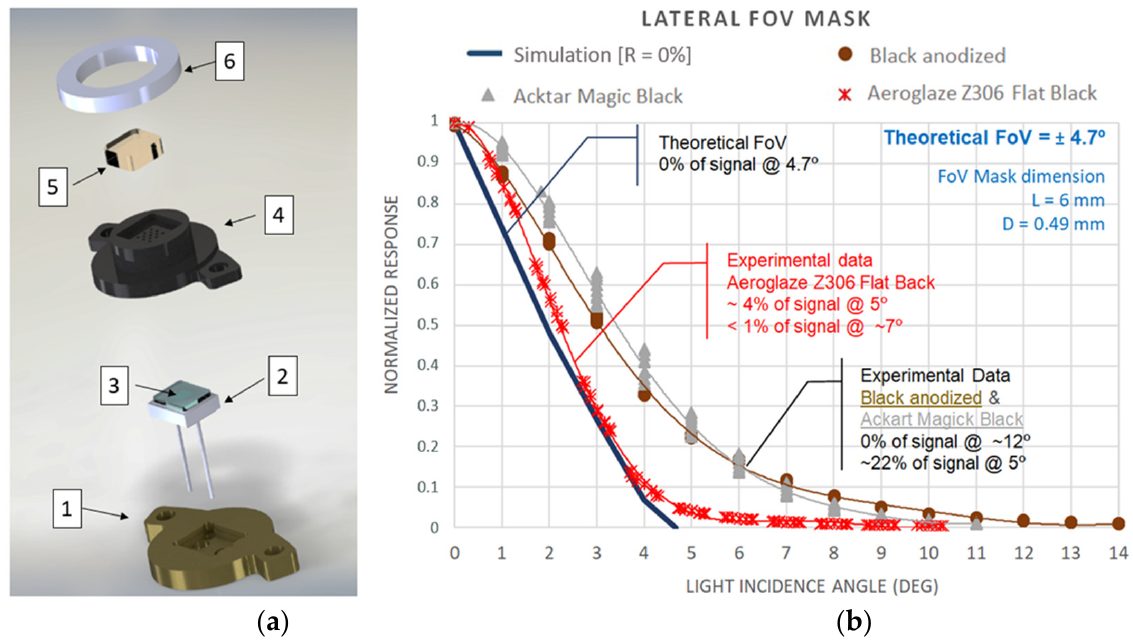
Figure 4. RDS optomechanical sets: ( a ) detail of the exploded view of a TOP channel subassembly: (1) radiation shield, (2) photodiode, (3) interferential filter, (4) FoV mask, (5) sapphire window, and (6) samarium–cobalt magnet; ( b ) normalized signal of a photodetector as a function of the light incidence angle for several FoV masks with the same mechanical dimensions but different surface treatments.